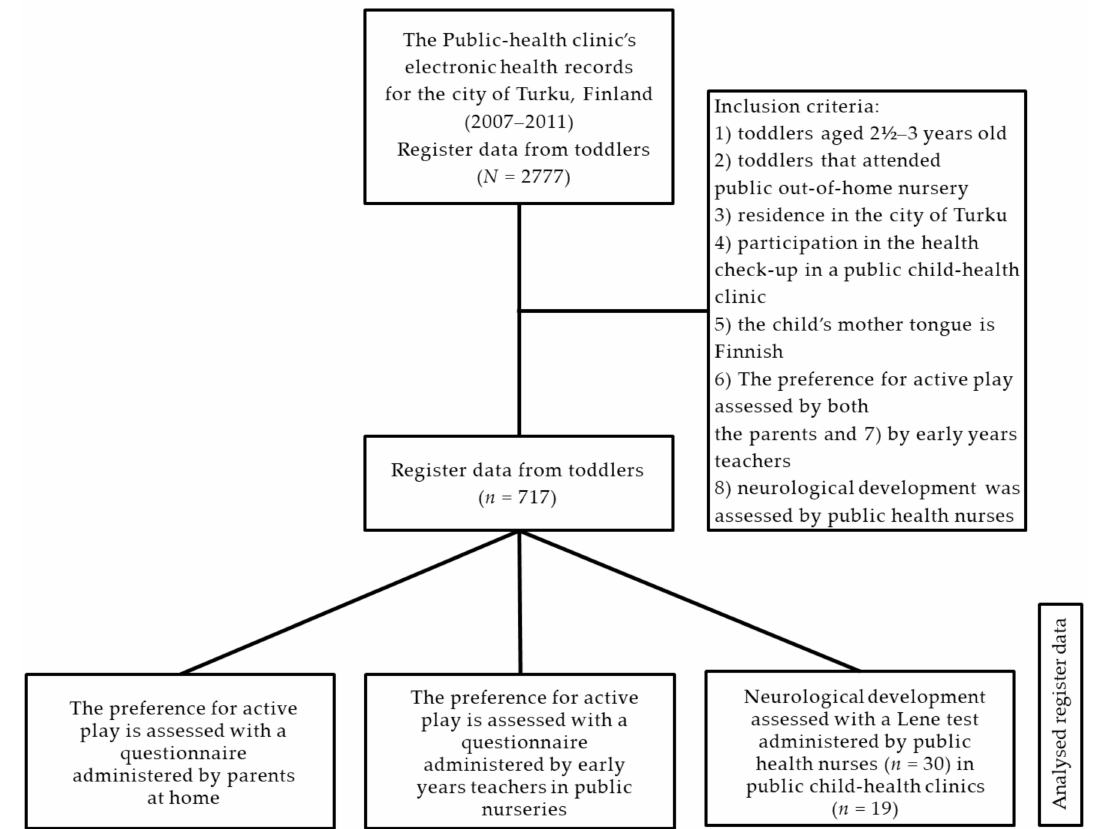
Figure 1. A flow chart of the research